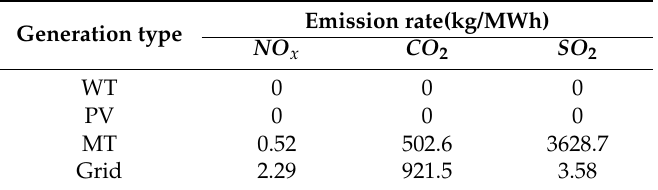
Table 2. Pollutant emission rate of different types of DGs.